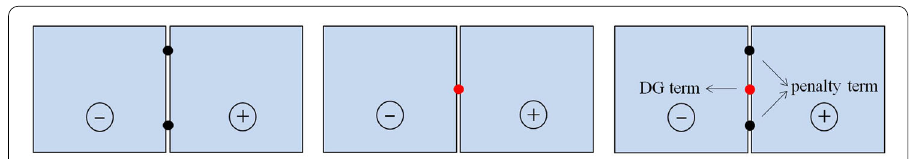
Fig. 2 DG interface with full (left), reduced (middle) and mixed (right) integration schemes for 2D elements